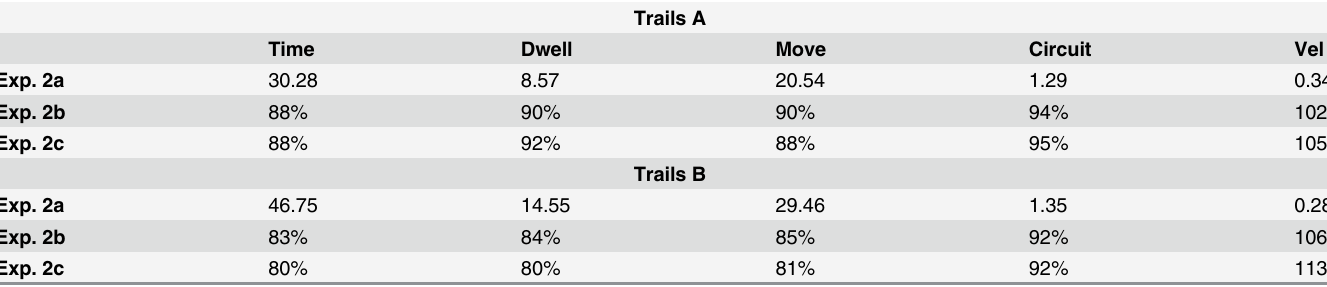
Table 6. Changes in performance across the repeated test sessions in Experiment 2.